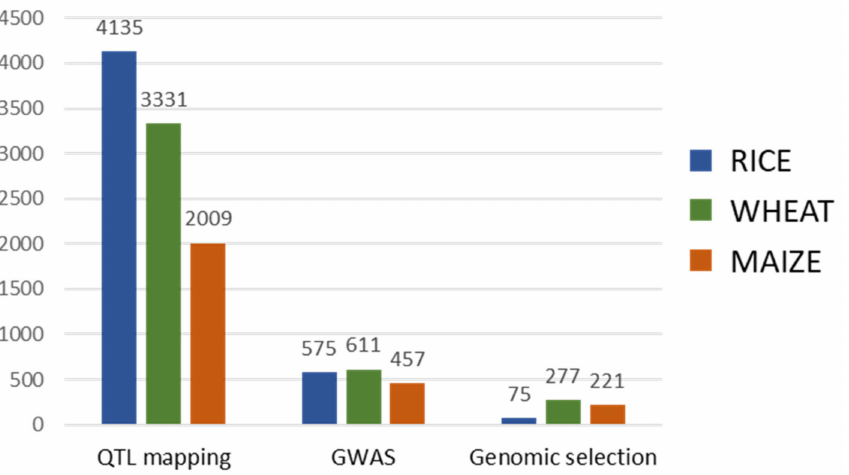
Figure 2. Number of bibliographic records referring to the main approaches for marker-assisted breeding in rice, wheat, and maize (source: Web of Science database, all years available; accessed 15 December 2020). QTL: Quantitative Trait Locus; GWAS: Genome-Wide Association